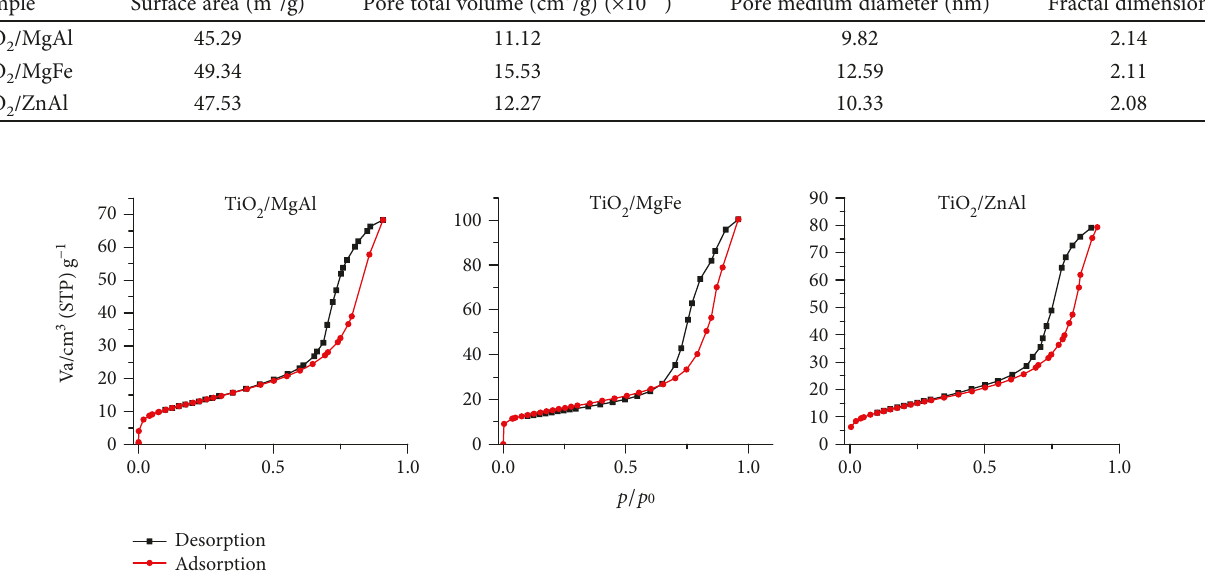
Table 2: BET surface area, total pore volume, and average pore diameter for TiO Sample